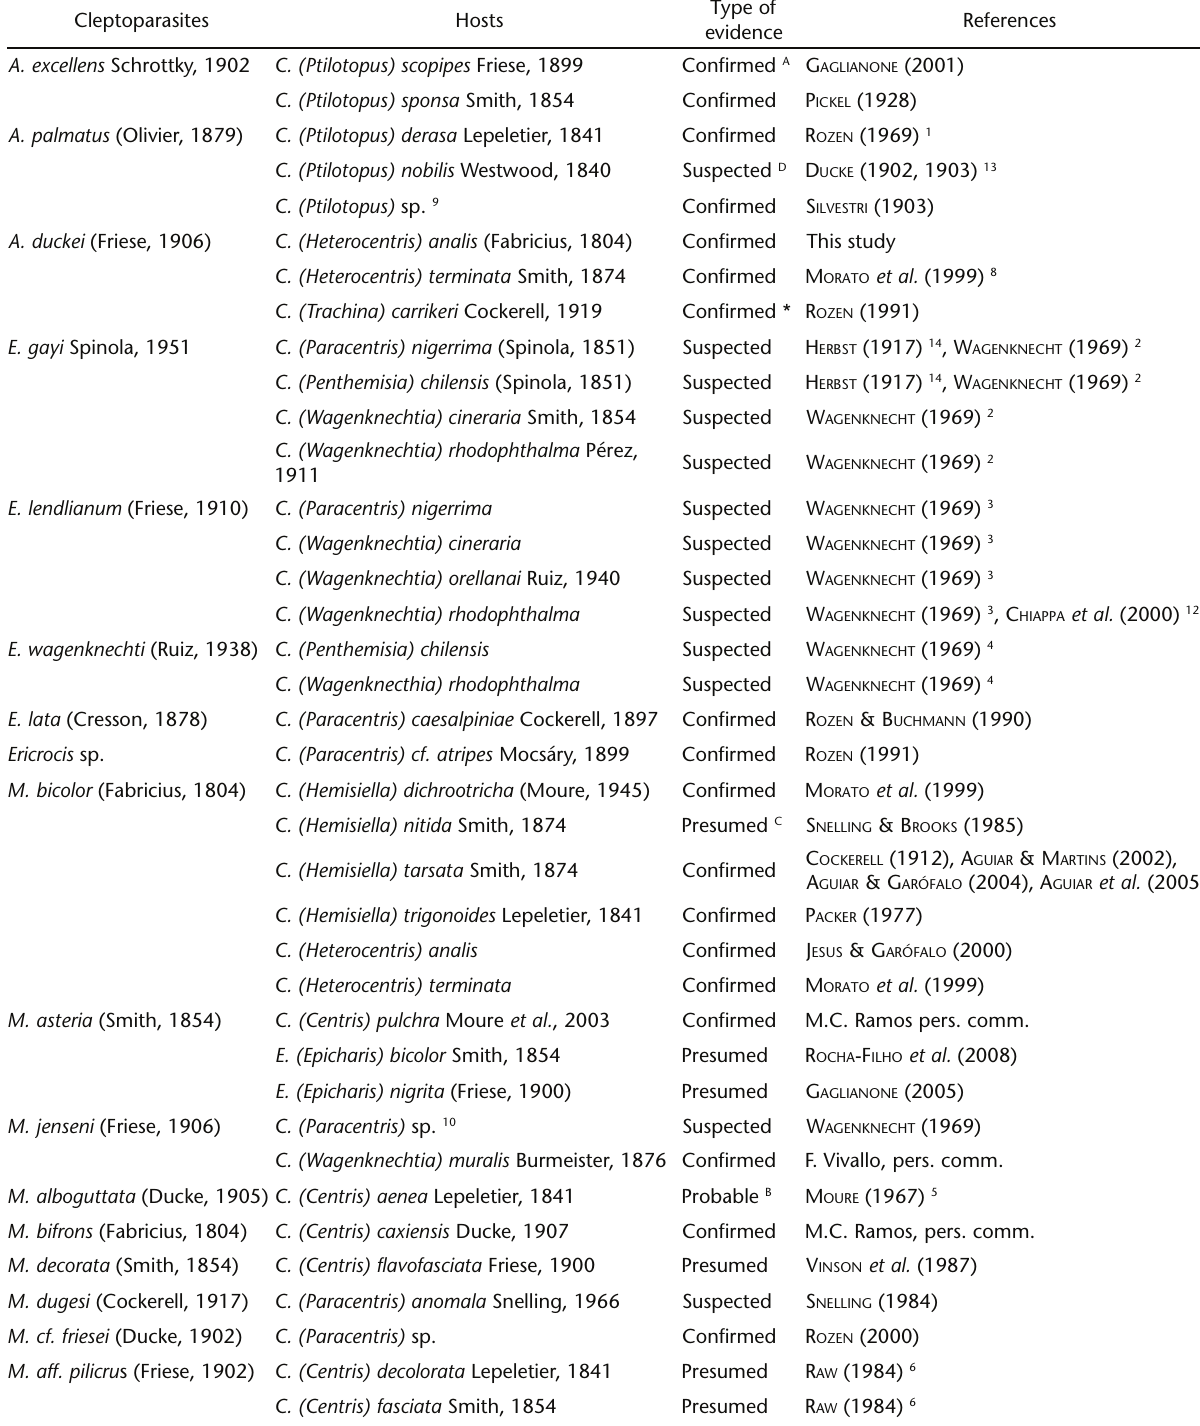
Table II. Known host associations for cleptoparasitic bees of the tribe